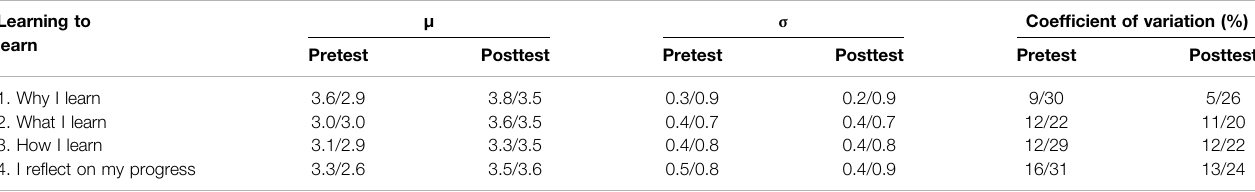
TABLE 3 | MAR (Community of Madrid Regional Archaeological Museum) vs. MG (Museum of Guadalajara), acquiring learning to learn competence (pretest – posttest) — descriptive statistics. Learning to